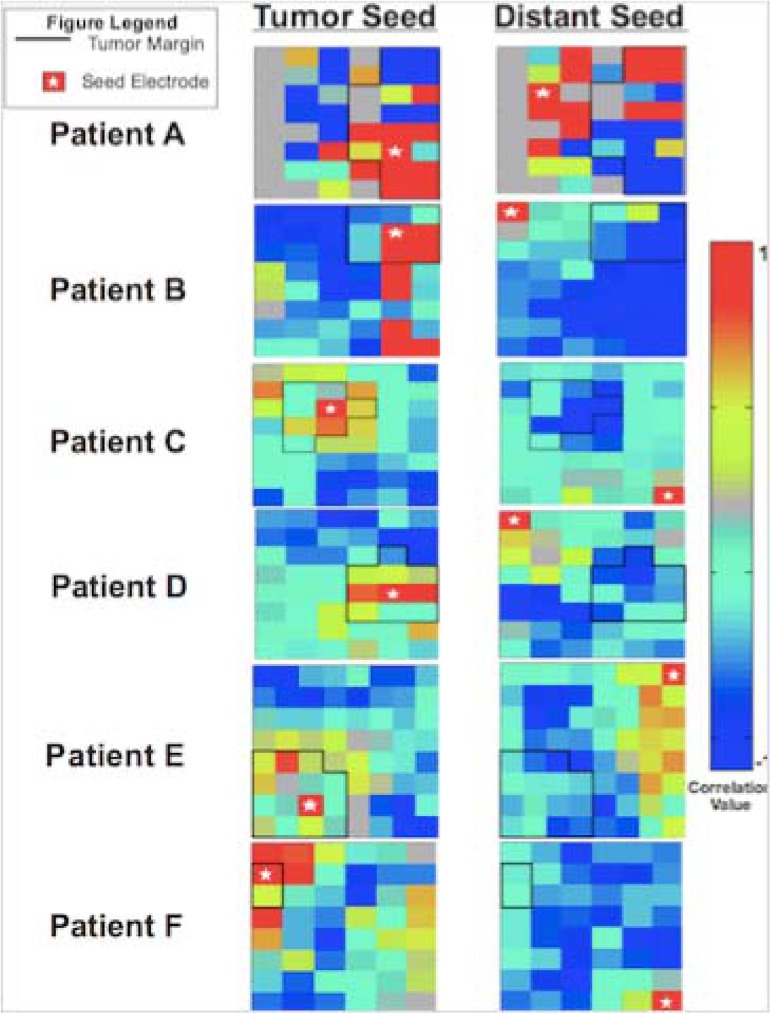
Patient specific correlation matrices demonstrating representative correlation maps with seeds placed centrally within each patient’s tumor (left column) and remotely within distant cortex (right column) for each individual subject.